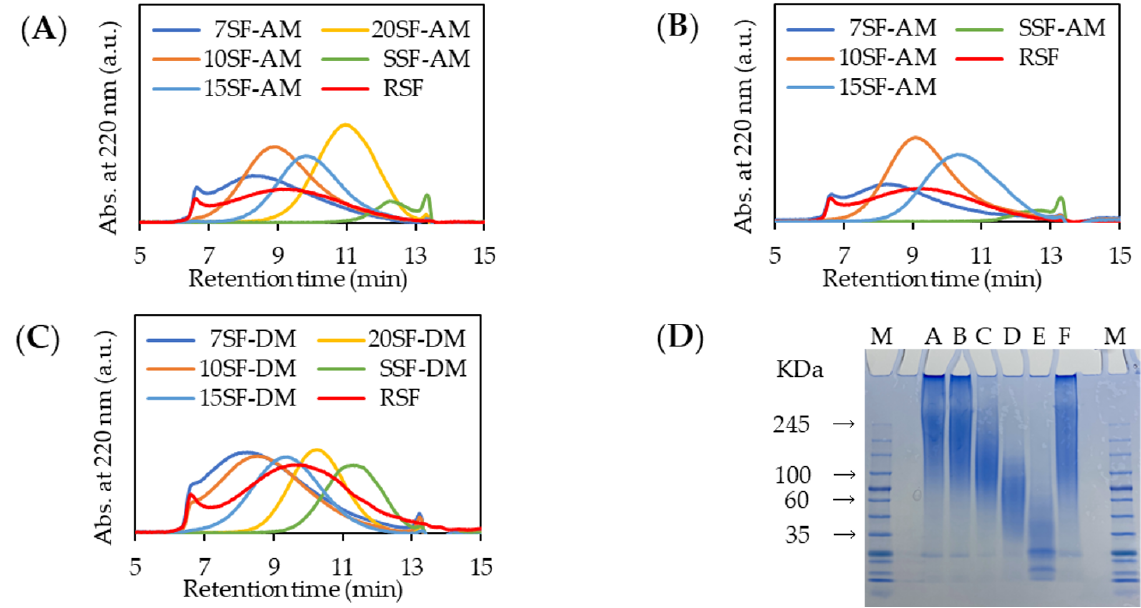
Figure 1. GPC elution profiles: ( A ) fractionated SFs by AM at 4 ◦ C, ( B ) fractionated SFs by AM at 37 ◦ C, ( C ) fractionated SFs by DM; ( D ) SDS-PAGE analysis of fractionated SFs by DM; Lane A, 7SF-DM; B, 10SF-DM; C, 15SF-DM; D, 20SF-DM; E, SSF-DM; F, RSF; and M, molecular weight